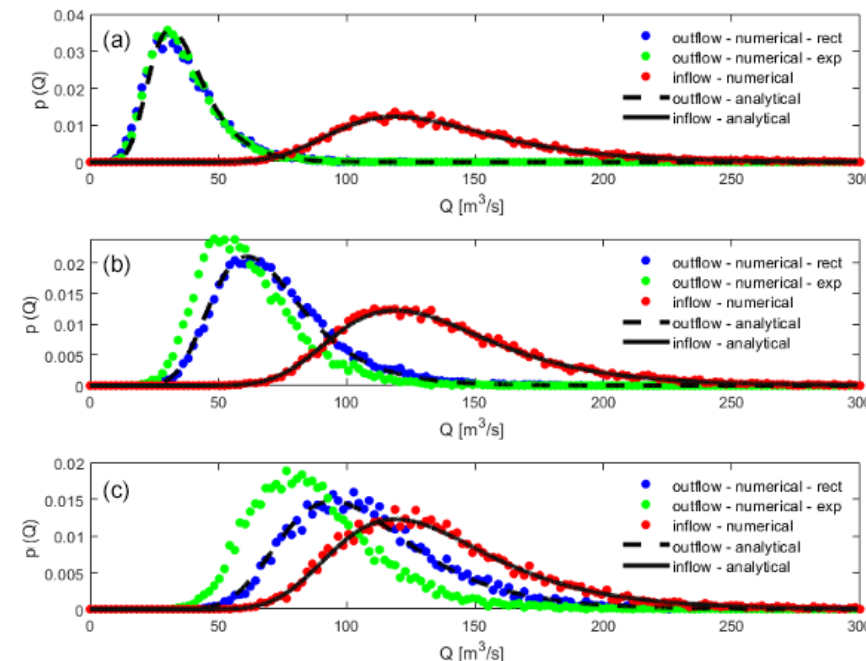
Figure 7. Comparison between derived probability density functions of the outflow (continuous black line for the inflow and dashed black line for the outflow) and the empirical PDFs obtained via numerical hydraulic simulation (red dots for inflow, blue dots for outflow obtained by incoming rectangular hydrographs and green dots for outflow obtained by incoming exponential hydrographs), assuming three equivalent event durations t p of half an hour (a) , 1h (b) and 2h (c) . Remaining parameters are α = 30m 3 /s; β = 120m 3 /s; w 1 = 5000; h s = 4m; b = 1m; d = 1m; n = 1 . 9; h f = d/ 2; µ f = 0 . 85; µ s = 0 . 385; L =